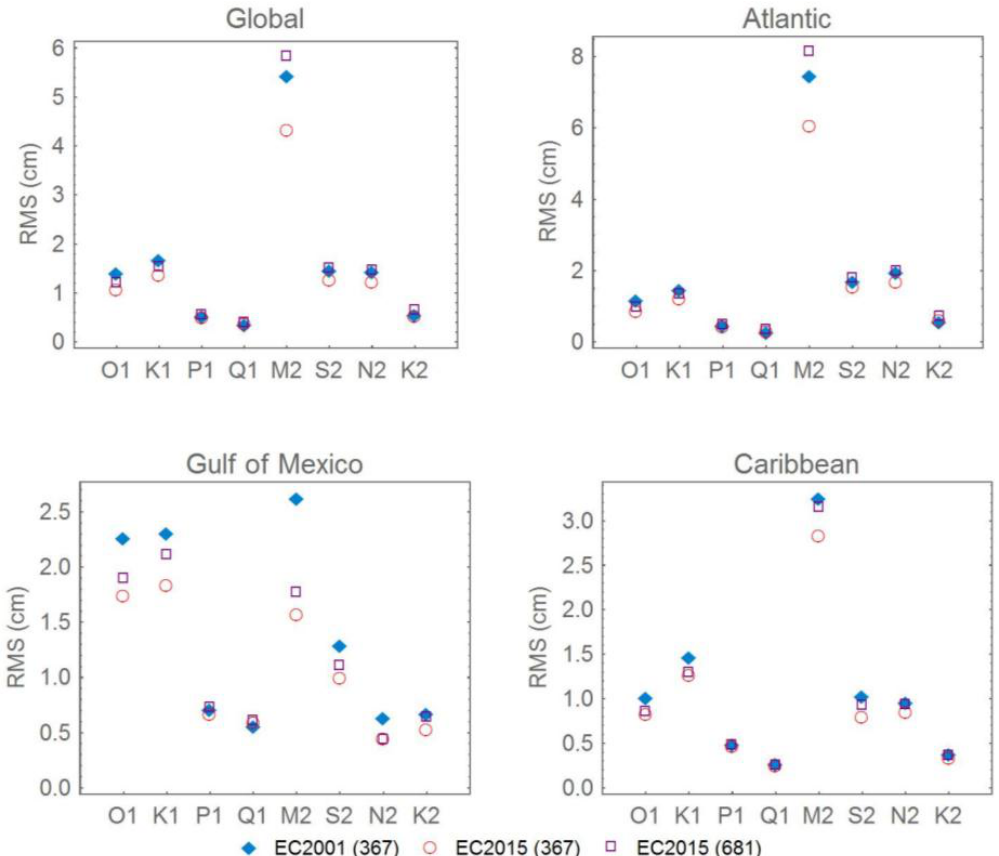
Figure 9. Mean RMS errors (cm) in harmonic constituents for the EC2001 and EC2015 ADCIRC tidal databases for each region of the WNAT model domain.